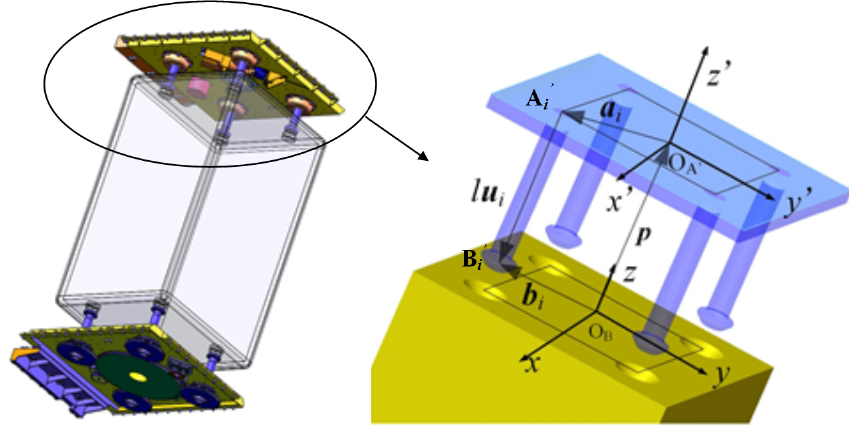
Figure 4. Assembled L/R mechanism with the SSMP and kinematic diagram for this simplified L/R